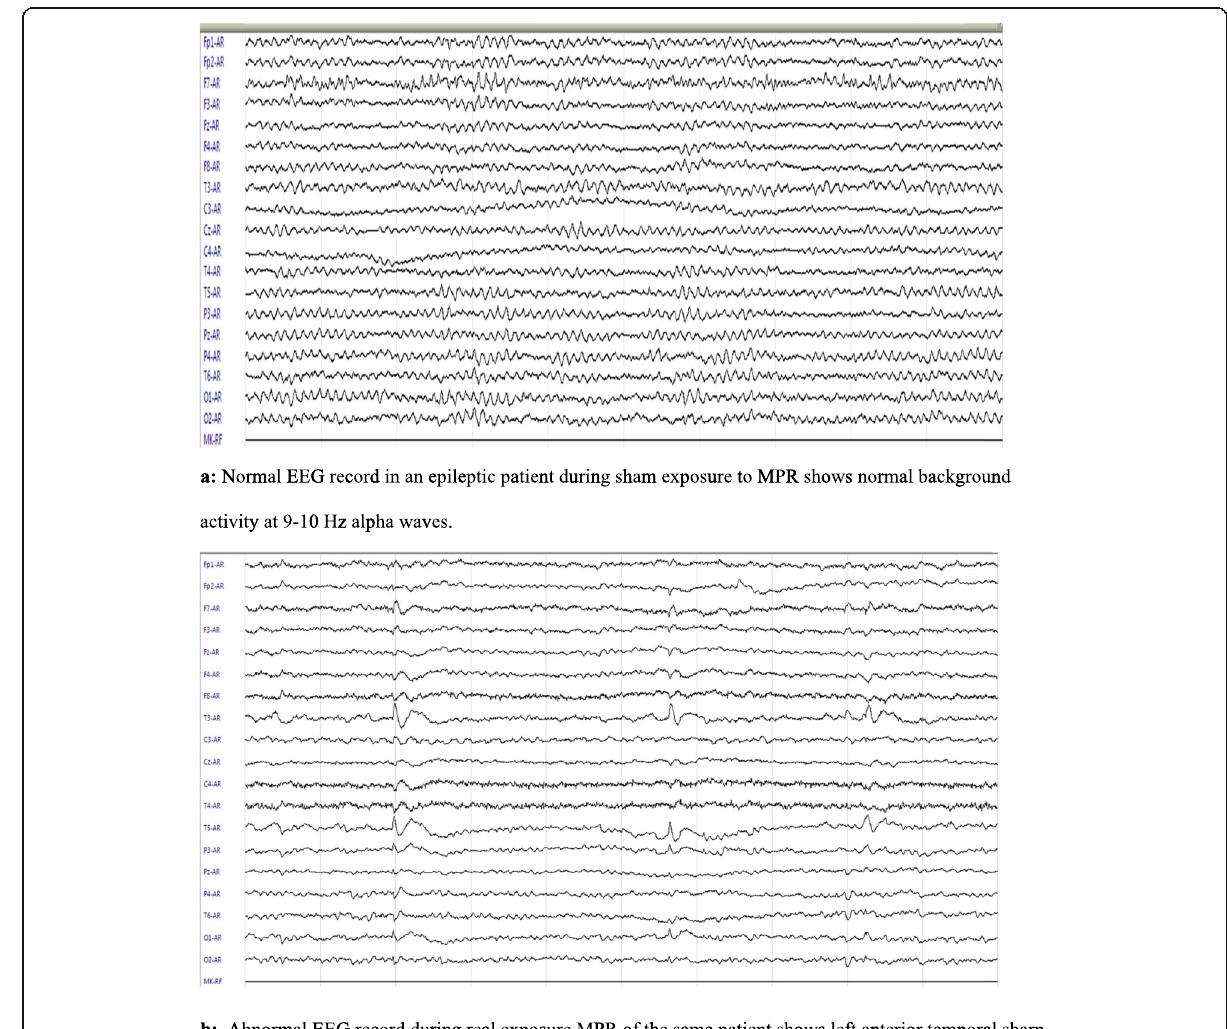
Fig. 1 a Normal EEG record in an epileptic patient during sham exposure to mobile phone radiation (MPR) shows normal background activity at 9 – 10 Hz alpha waves, using a referential montage with gain set on 10 uV . b Abnormal EEG record during real exposure to MPR of the same previous patient shows left anterior temporal (T3/T5) sharp-slow wave complexes, using a referential montage with gain set at 15 uV. The background activity became slightly slowed at 7 – 8 Hz